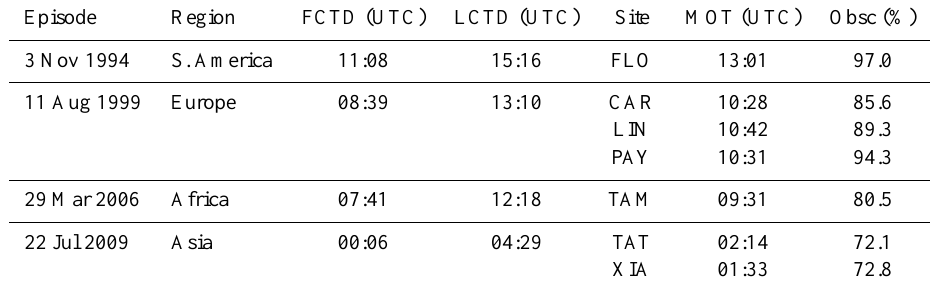
Table 1. Overview of the parameters that describe the eclipse episodes at the selected sites. FCTD is the First Contact Time in Domain, LCTD is the Last Contact Time in Domain, MOT is the Maximum Obscuration Time and Obsc refers to the degree of obscuration.